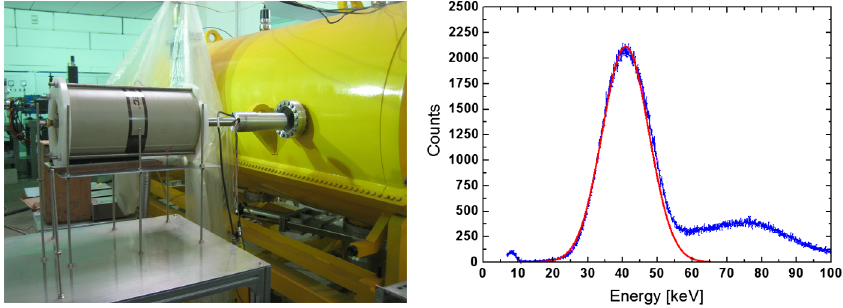
FIG. 22. The setup for the X-ray spectrum measurement.